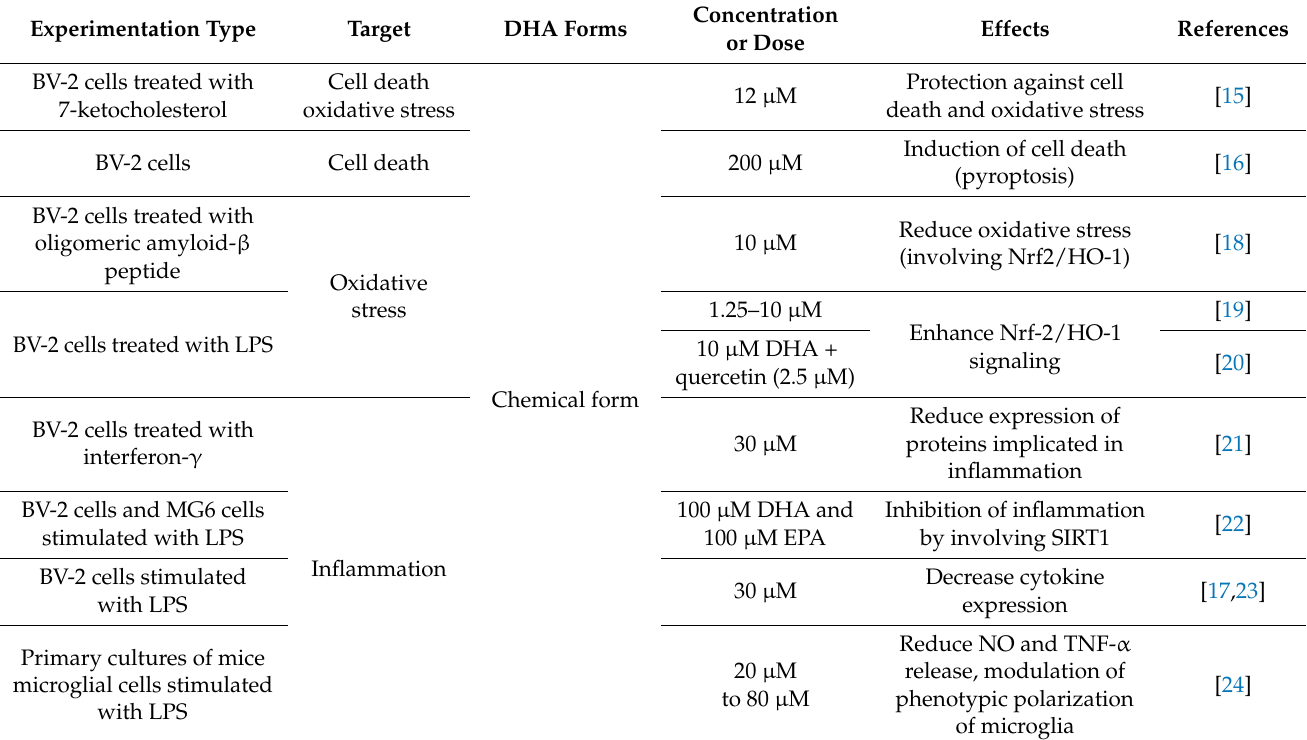
Table 1. In vitro data on the effect of DHA on cell death, oxidative stress, and inflammation. Experimentation